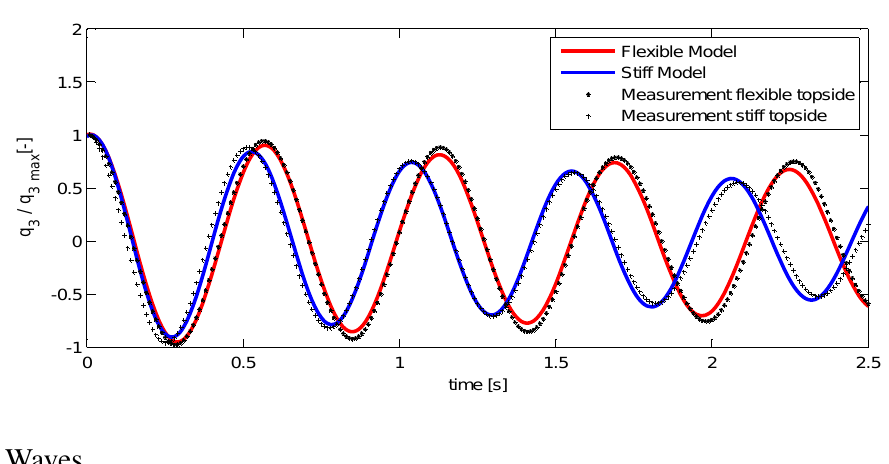
Figure 9. Code-to-experiment comparison between the flexible hybrid model and the stiff hybrid model and the experimental data in a pitch decay test, normalized by the displacement in pitch at t = 0.